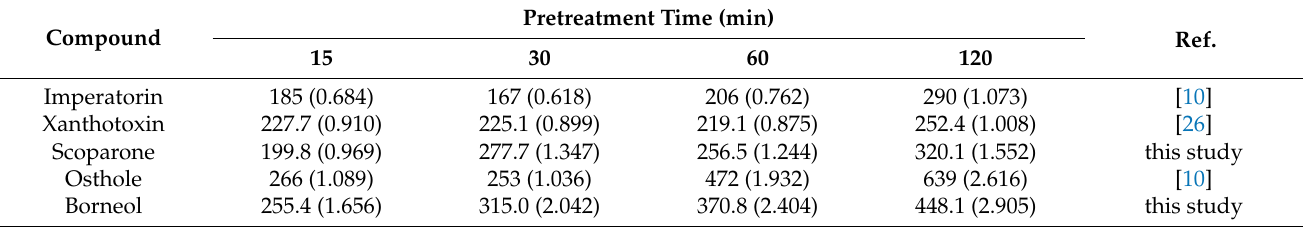
Table 4. Anticonvulsant potencies of various naturally occurring compounds in the mouse MES